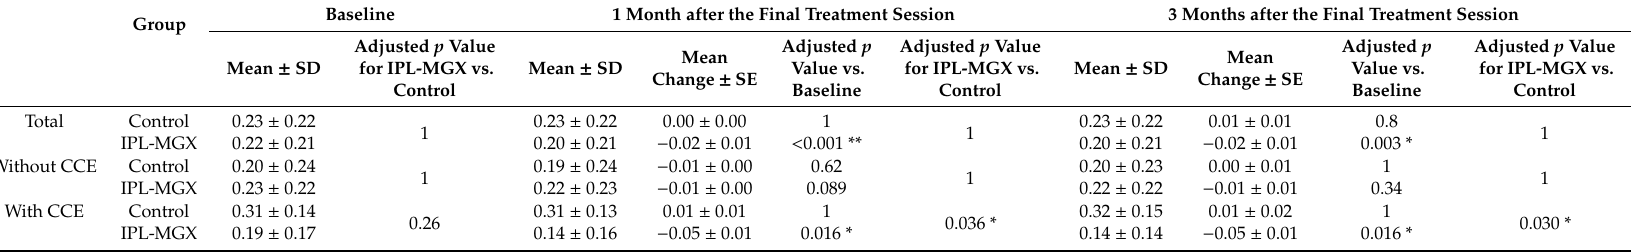
Table 5. Logarithm of the minimum angle of resolution (logMAR) visual acuity of the study subjects with or without central corneal epitheliopathy (CCE) in the intense pulsed light (IPL)—meibomian gland expression (MGX) group ( n = 12 and 32, respectively) and MGX (control) group ( n = 11 and 29, respectively) at baseline as well as 1 and 3 months after the final treatment